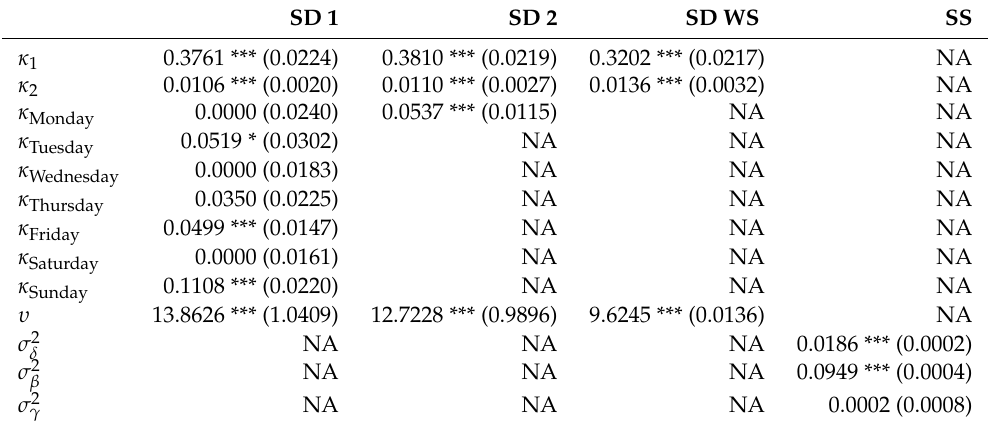
Table A10. Parameter estimates for